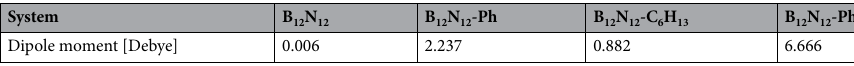
Table 2. Dipole moment of the bare and grafted B 12 N 12 nanocage cluster.